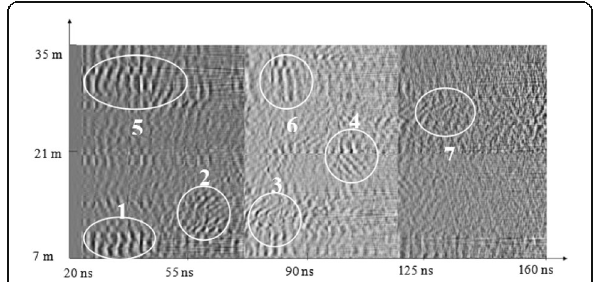
Fig. 19 First measurement from bottom to